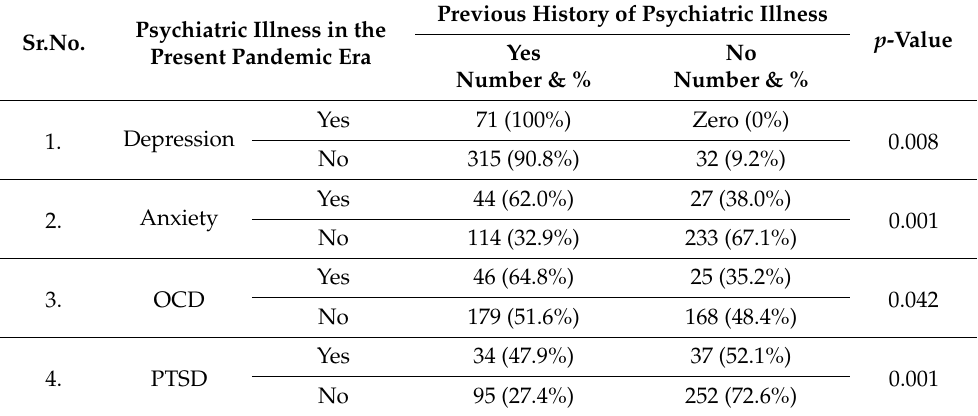
Table 3. Relation between previous history of psychiatric illness and the prevalence of different psychiatric illness in the present pandemic era.